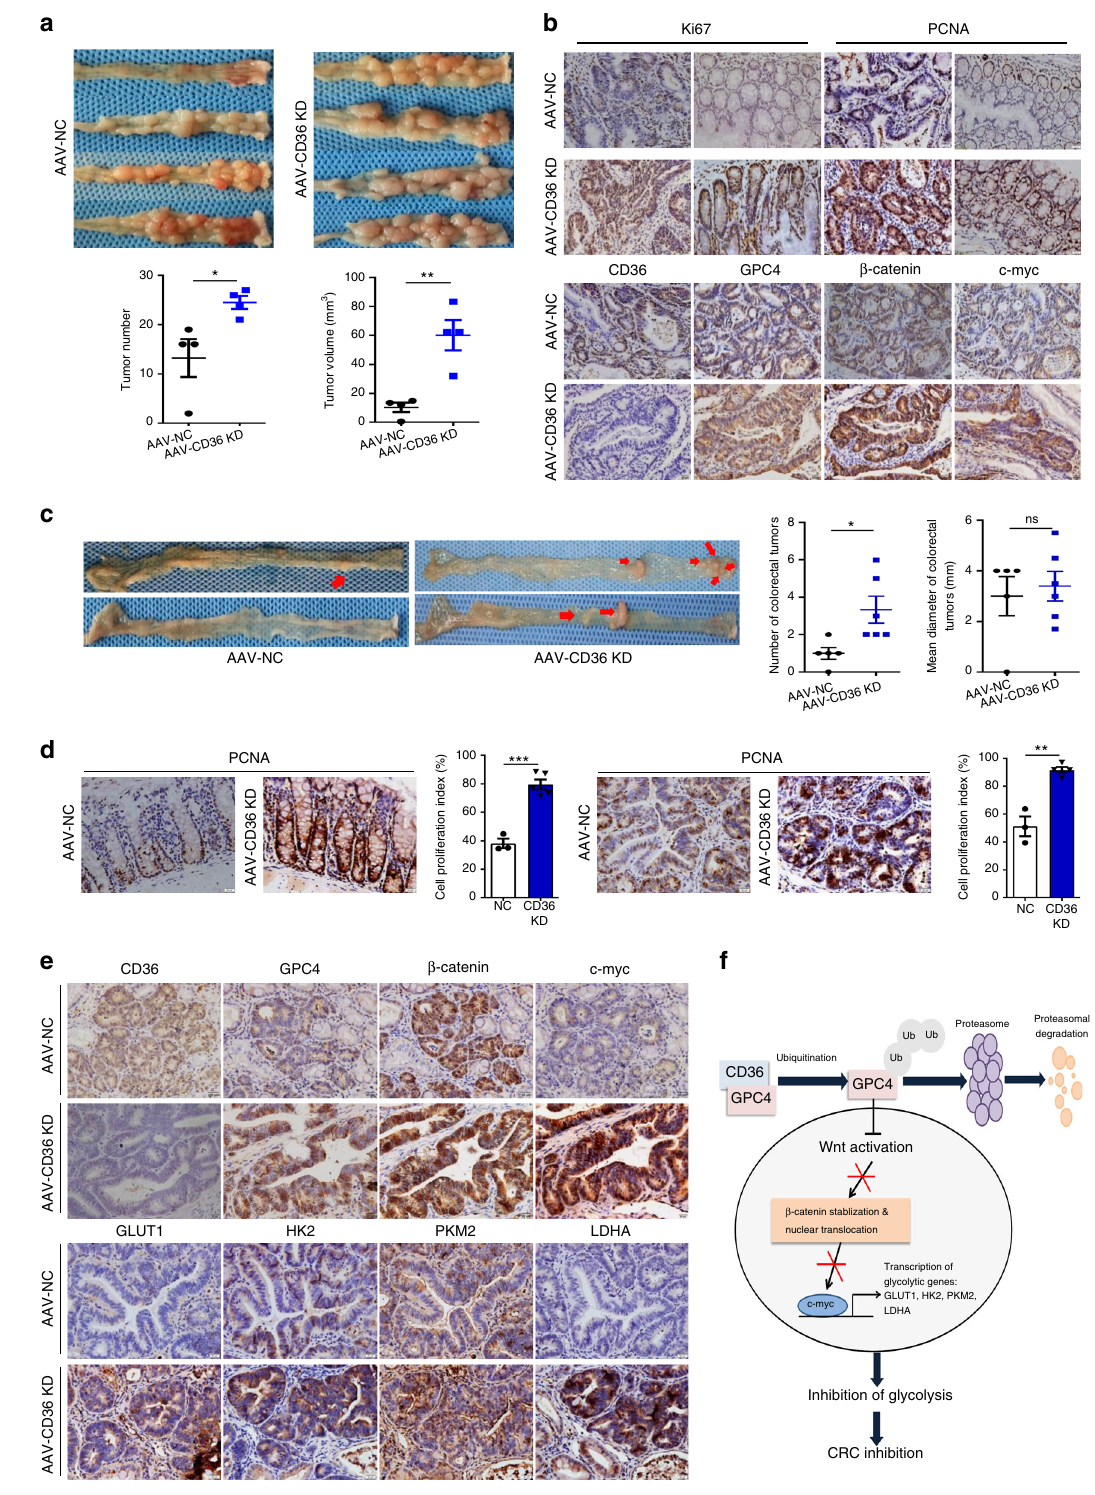
Fig. 7 AAV-mediated CD36 knockdown promotes CRC. a Macroscopic appearance of tumors in the large intestines of AOM-DSS-induced mice. Intestinal tumor numbers and tumor volumes were measured. b Representative images of IHC staining of indicated targets on tumor sections. Scale bar, 20 μ m (40×). c Macroscopic appearance of tumors in the large intestine of Apc Min/ + mice, statistical analysis of tumor numbers and sizes in the colon and rectum. d Representative IHC staining of PCNA, cell proliferation index was calculated as before. All statistical results are shown as mean ± SEM, based on Student ’ s t -test, * P < .05, ** P < .01, *** P < .001. e Representative images of IHC staining of CD36, GPC4, β -catenin, c-myc, and downstream glycolytic genes GLUT1, HK2, PKM2 and LDHA on the tumor sections. Scale bar, 20 μ m (40×). f Schematic diagram summarizing our working model, namely, CD36 can interact with and induce the proteasome-dependent ubiquitination of GPC4, thereby inhibiting β -catenin/c-myc signaling, followed by repressed glycolytic activity and colorectal tumor suppression. Source data are provided as a Source Data fi